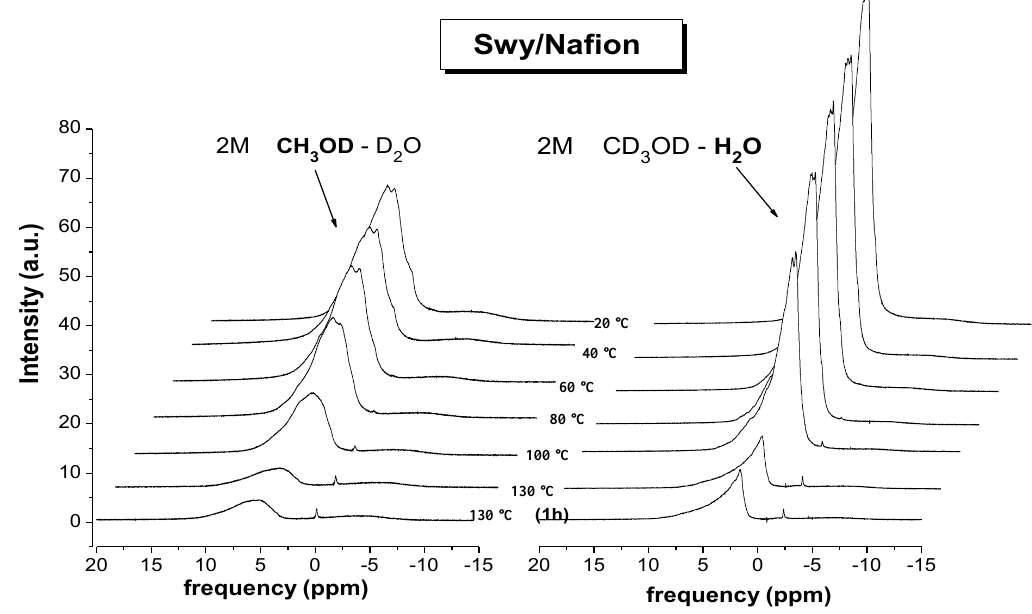
Figure 5. Evolution of proton spectra from methanol (on the left) and water (on the right) as a function of temperature on Swy/Nafion composite swollen in 2 M methanol solution. The spectra were referenced setting methyl protons and pure water at 0 ppm,